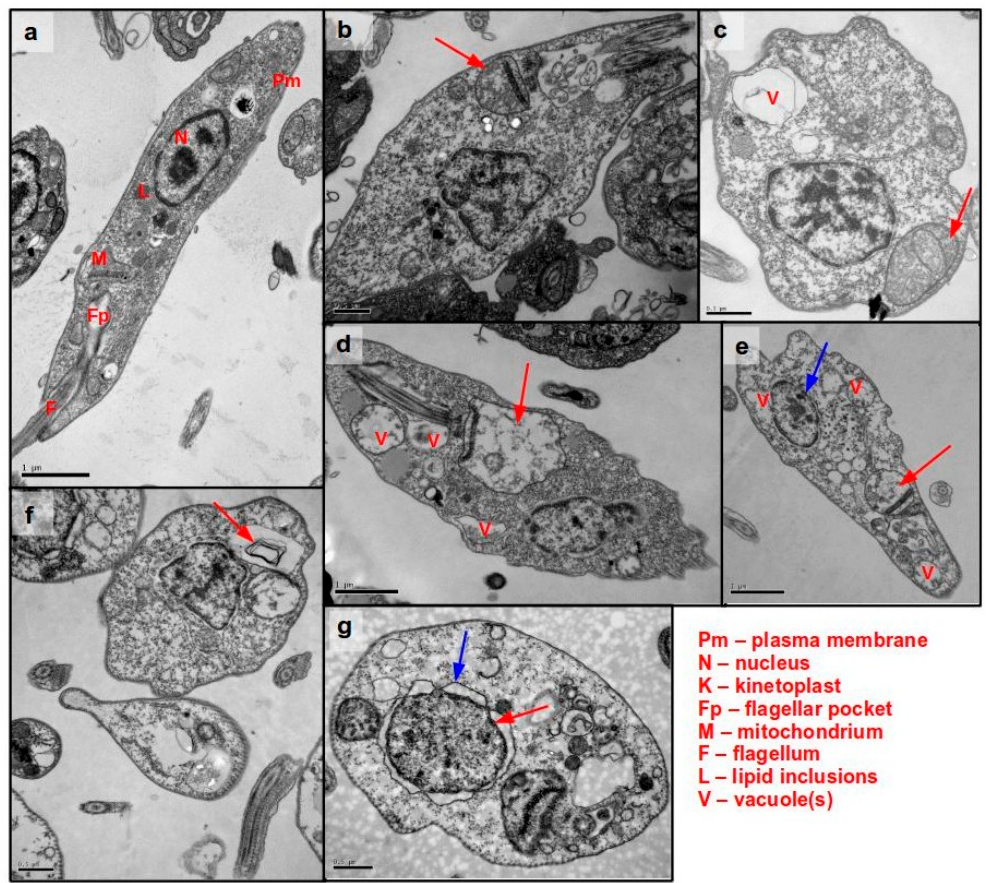
Figure 4. Transmission electron microscopy imaging of L. (L.) infantum promastigotes treated with helenalin acetate ( 1 ). 2 × 10 7 promastigotes/well were incubated with 1 for different periods of time. ( a ) Untreated control. ( b ) 0.5 h; ( c ) 1 h; ( d ) 2 h; ( e , f ) 3 h; ( g ) 4 h. The figure shows representative images taken from one out of two independent experiment. The observed ultrastructural observations appeared consistently in both independent Transmission Electron Microscopy (TEM) experiments.